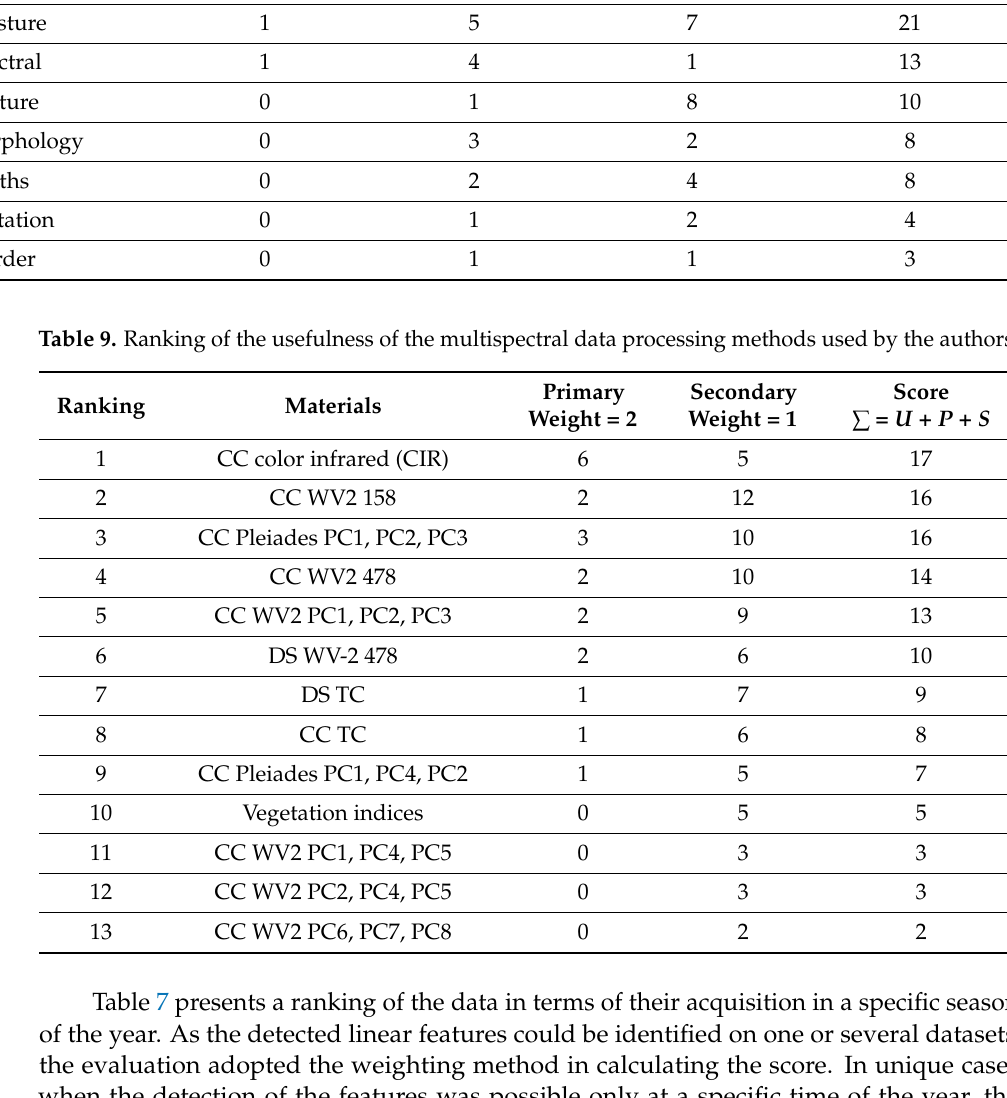
Table 8. Ranking of usefulness of photointerpretation features in the analysis of multispectral data. Photointerpretation Feature Ranking